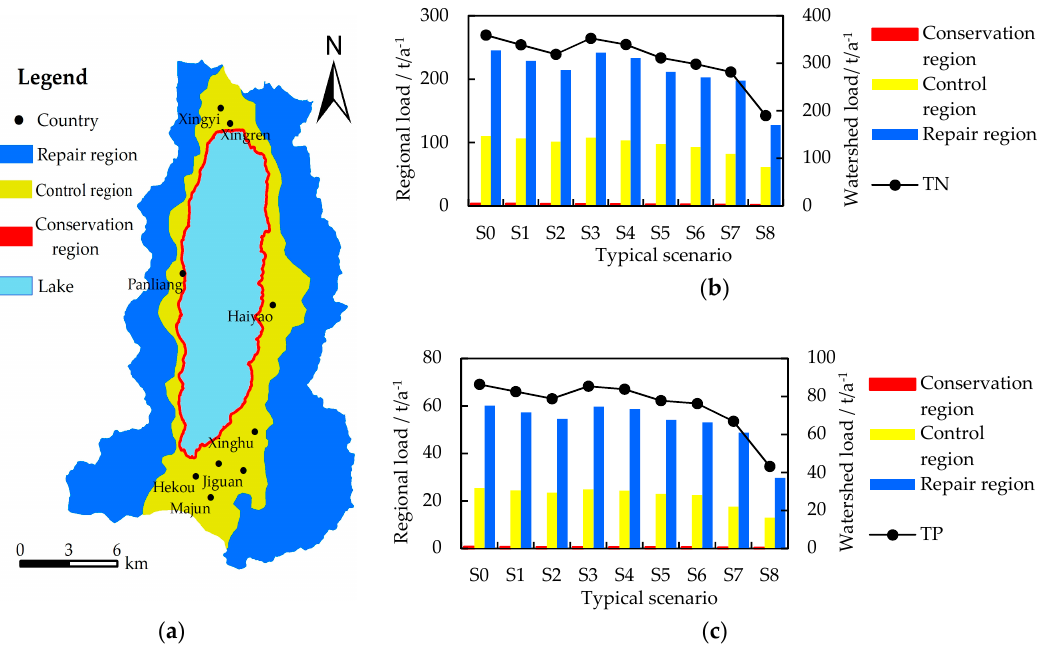
Figure 14. NPS pollution prevention and control zones in the Chenghai Lake watershed ( a ) and regional load in different scenario for TN ( b ) and TP ( c ).